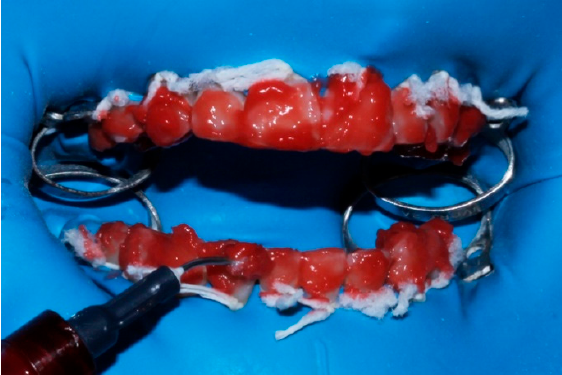
Figure 1. In-office chemoactivatable bleaching product containing 40% hydrogen peroxide applied to patient’s teeth.